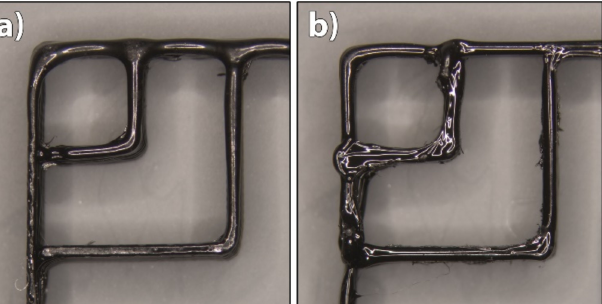
Figure 5. Images of 3D printed TPU test samples printed at different printing speeds: ( a ) 10 mm/s and ( b ) 20 mm/s.